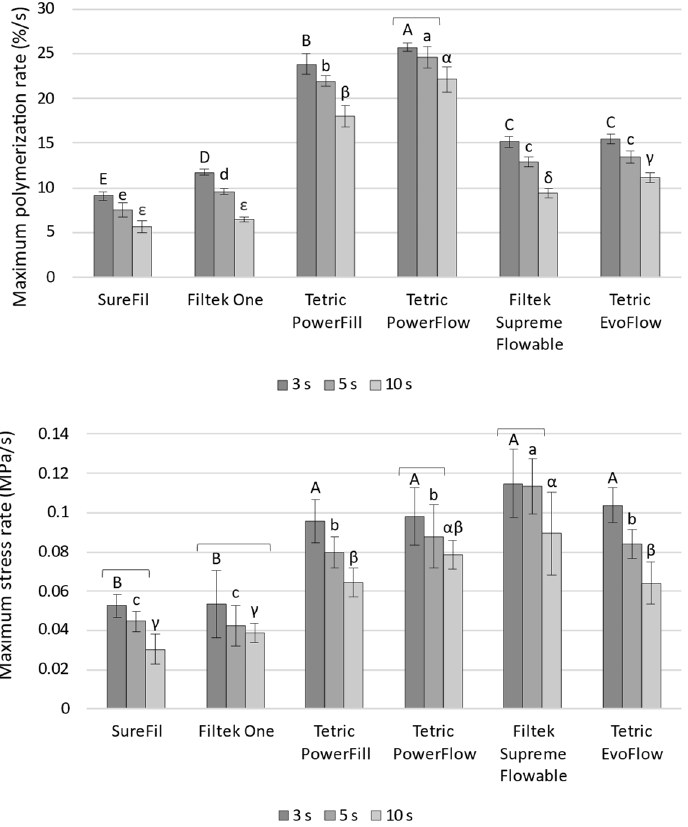
Figure 2. Maximum polymerization rate and maximum shrinkage stress rate (mean values ± 1 SD). Statistically similar values among curing protocols are connected with square brackets. Statistically similar values among materials are denoted by same uppercase, lowercase, and Greek letters for the 3, 5, and 10 s curing protocols, respectively.